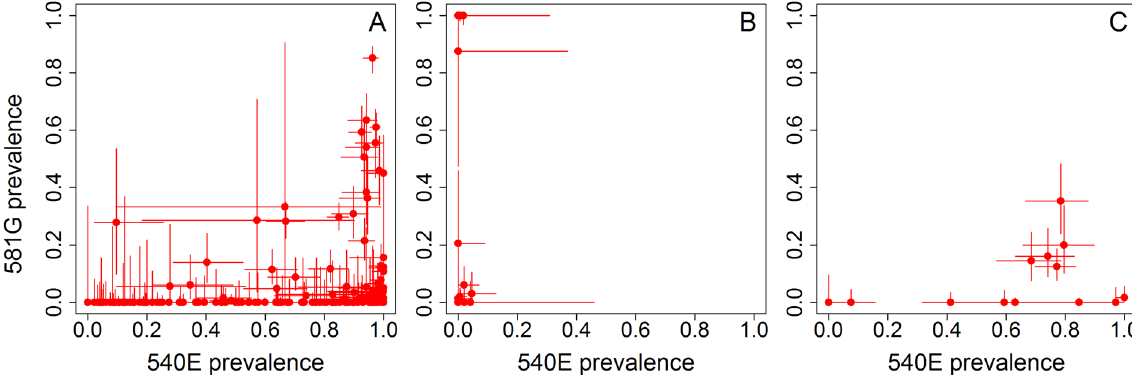
Figure 6. Relationship between prevalence of 540E and 581G mutations when measured in the same individuals in ( A ) Eastern and Southern Africa (n = 172), ( B ) West Africa (n = 50), ( C ) Northeast Africa (n = 15) using surveys from 1988–2013. Mixed infections contribute to some of these measures, therefore the haplotype is unknown for most samples (i.e. the two mutations could be present together on one parasite or separately on different parasites). The sample size for assessing the prevalence of the two mutations was not always identical, usually due to different PCR success rates. Data in Eastern and Southern Africa were from the Democratic Republic of the Congo, Kenya, Mozambique, Malawi, Rwanda, Tanzania, Uganda, South Africa and Zambia; in West Africa from Angola, Benin, Burkina Faso, Côte d’Ivoire, Cameroon, Ghana, Equatorial Guinea, Mali, Mauritania, Niger and Senegal; and Northeast Africa from Ethiopia, Sudan and